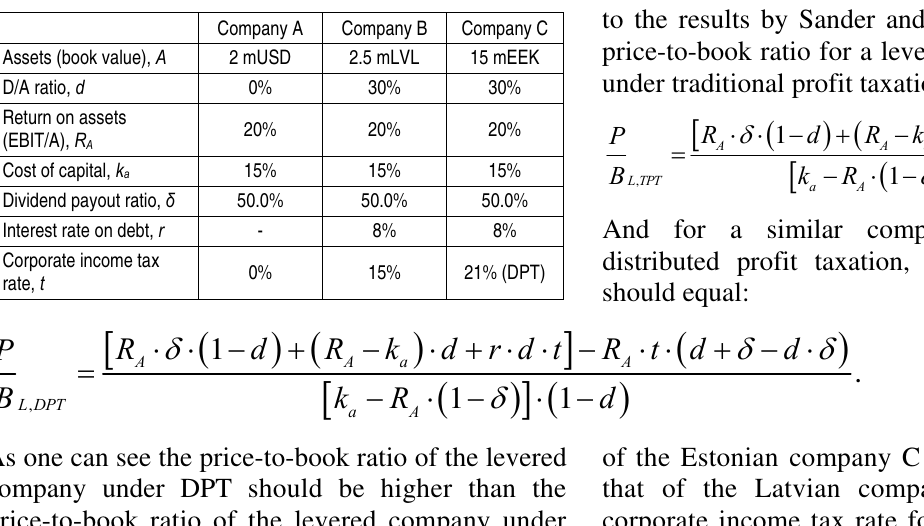
Table 1. Quantitative inputs for valuation